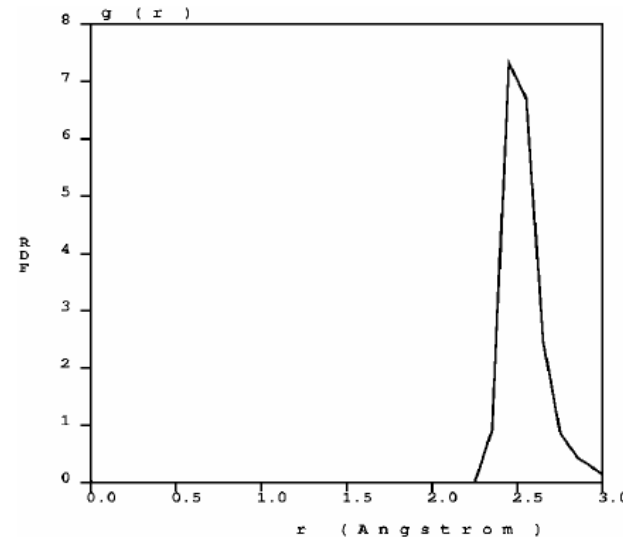
Figure 9. The first peak of the RDF of nanosilicon has a structure due to the interatomic distances on the surface of the pore (2.55 Å) and within the bulk (2.45 Å). It has been shown that the larger the number of atoms in the supercell, the interatomic distance becomes closer to 2.35 Å, the crystalline value